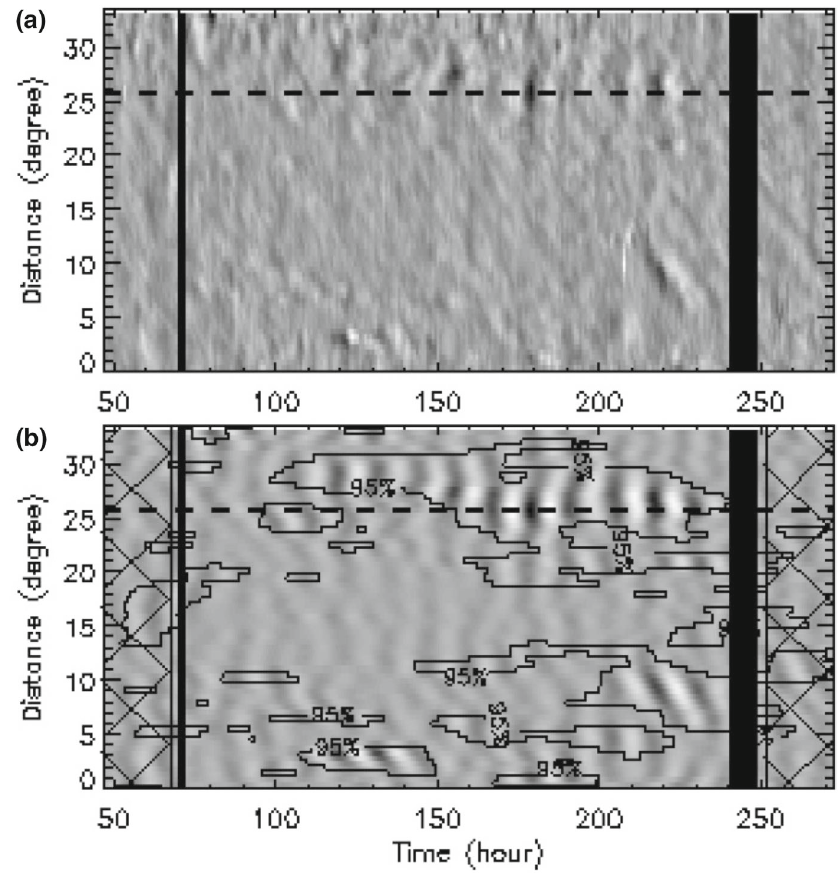
Fig. 19 a Time–space diagram of the 195 Å image intensity along the main axis of a filament. The vertical black stripes are caused by the lack of observational data. b Spatial distribution of the Fourier phase (gray coloured contours). Image reproduced with permission from Foullon et al. (2004), copyright by